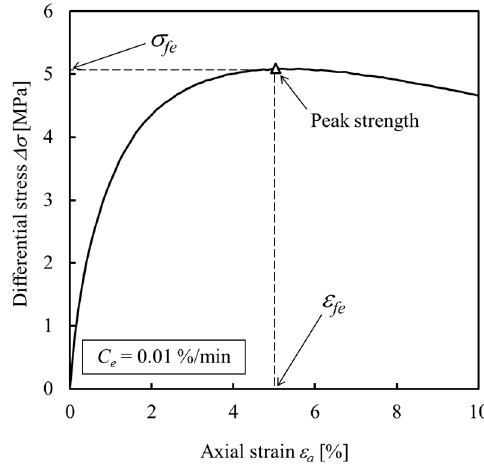
Figure 2. Differential stress ∆ σ versus axial strain ε a in constant-strain-rate test [18,21].